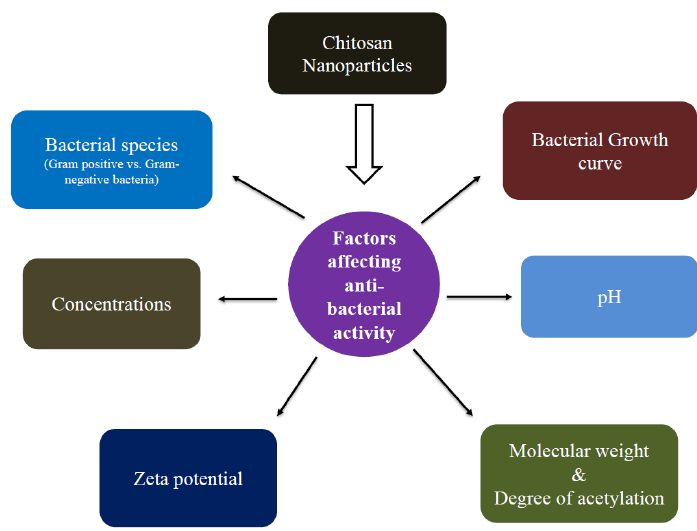
Figure 4. Factors a ff ecting antibacterial activity of chitosan Figure 4. Factors affecting antibacterial activity of chitosan nanoparticles.